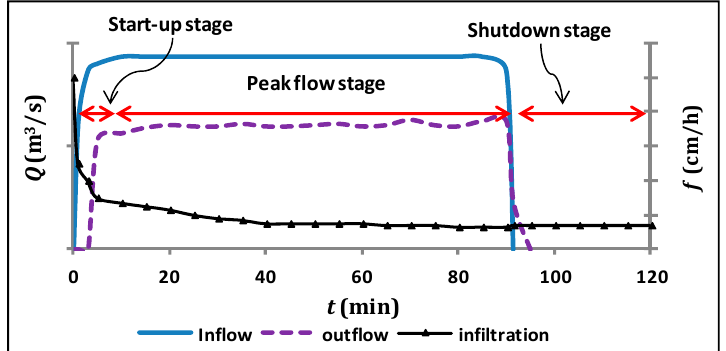
Figure 5. The typical hydrograph of flow along the channel during experiments, showing three flow stages.